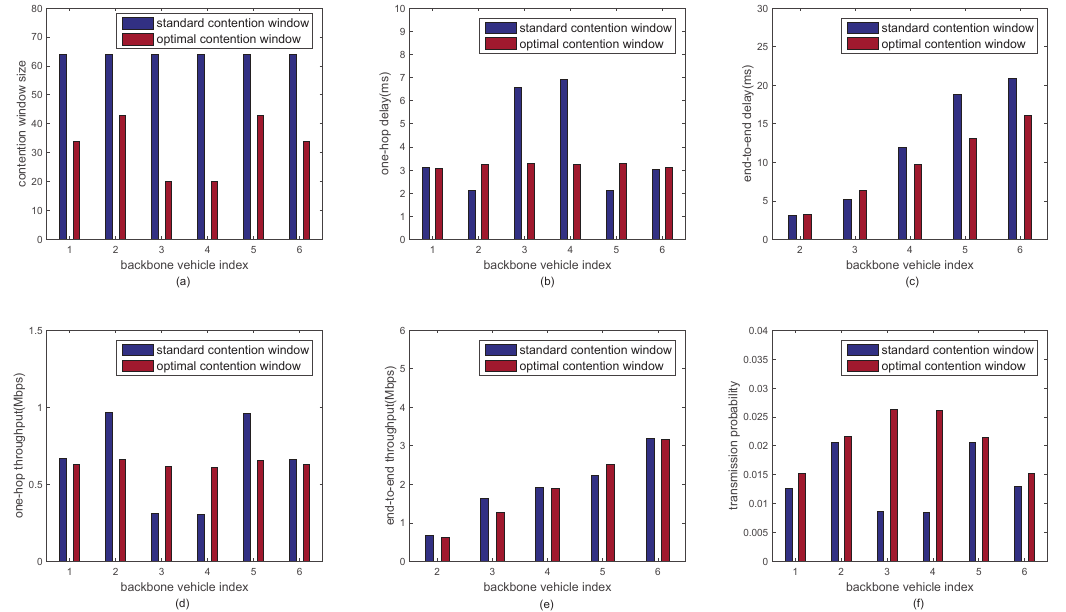
Figure 5. The performance of inter-platoon communications under six backbone vehicles. ( a ) Minimum contention window size vs backbone vehicle index; ( b ) One-hop delay vs backbone vehicle index; ( c ) End-to-end delay vs backbone vehicle index; ( d ) One-hop throughput vs backbone vehicle index; ( e ) End-to-end throughput vs backbone vehicle index; ( f ) Transmission probability vs backbone vehicle